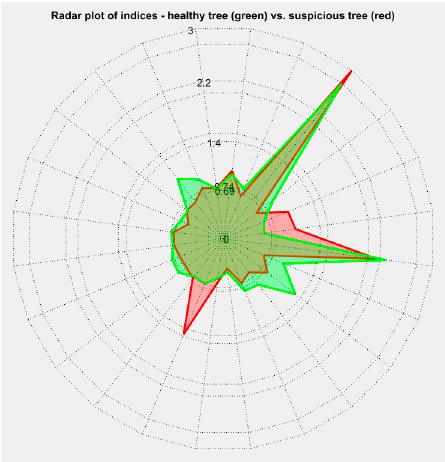
a) multispectral data; b) hyperspectral data.